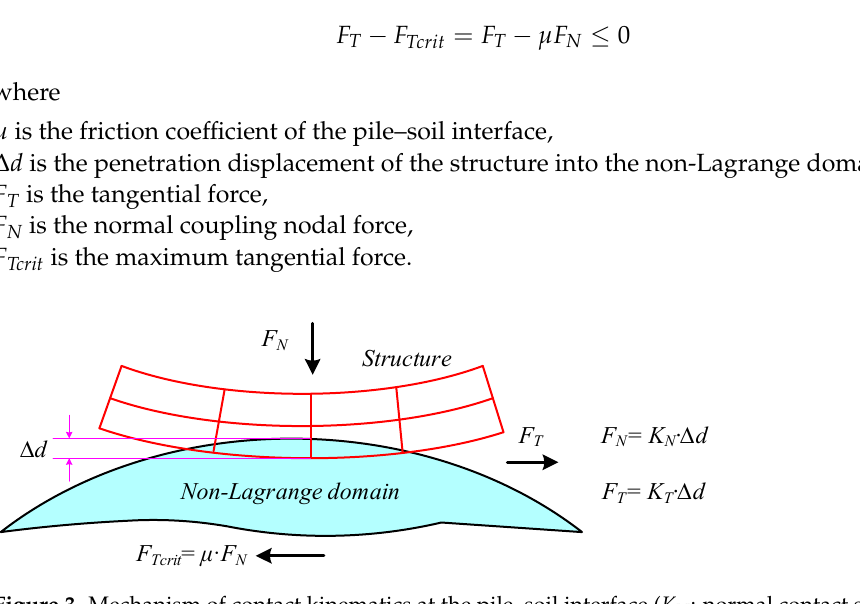
Figure 3. Mechanism of contact kinematics at the pile–soil interface ( K N : normal contact stiffness; K T : tangential contact stiffness).